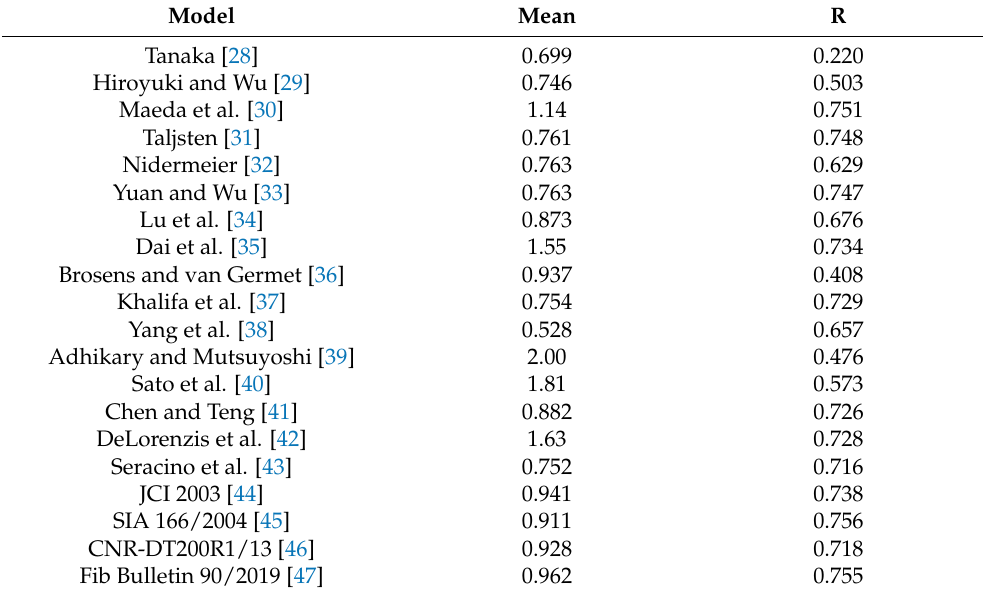
Table 1. Predicted experimental bond strength ratios for SRP composites bonded to concrete